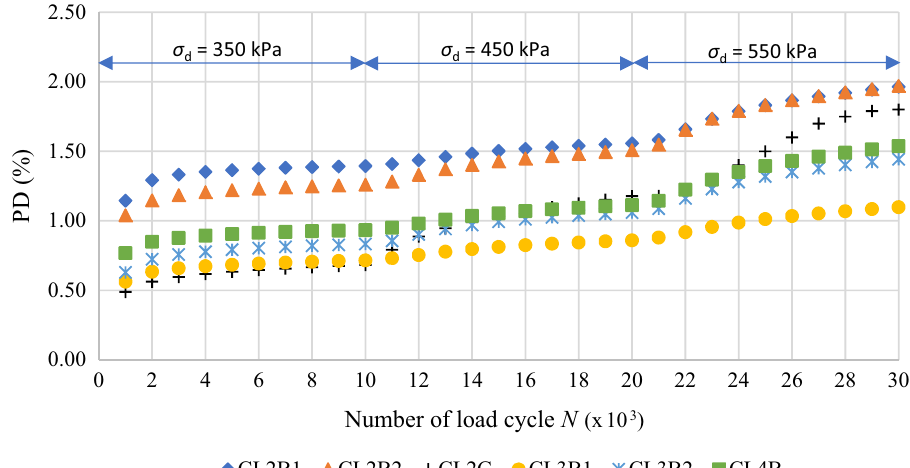
Fig. 9 Effect of number of load cycles